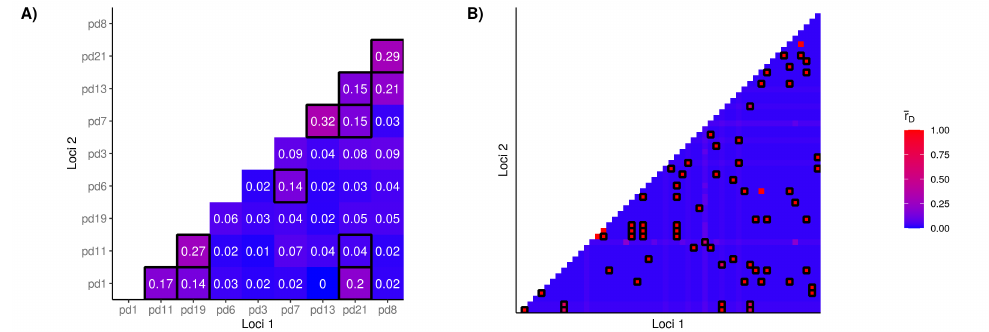
Figure 2. Pairwise comparison of the results from standardized index of association tests ( rD ), conducted on Microsatellite ( A ) and SNP ( B ) datasets. Squares of the heatmap outlined in black highlight combinations of loci where rD p -value < 0.05, consistent with null-expectations under clonality. Samples missing greater than 5% of genotype calls were